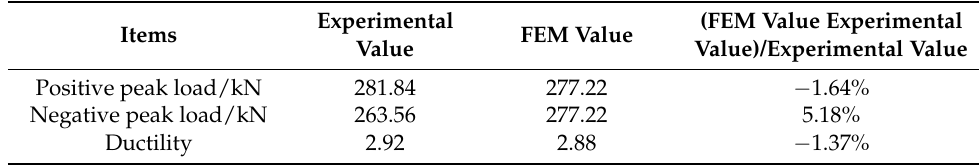
Figure 8. Comparison of load–displacement curves for PUTCCS between FEM and experimental results. Table 2. Comparison of peak load and ductility for PUTCCS between FEM and experimental results.